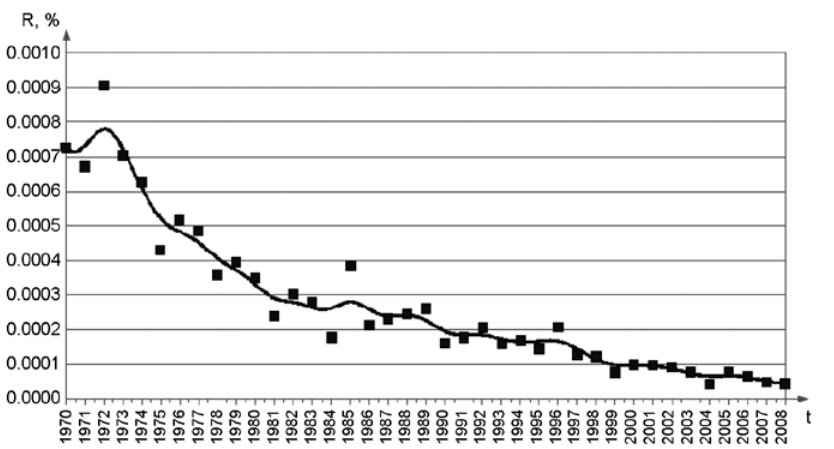
Fig. 1. The percentage of people who died in air accidents relative to all carried passengers in the period between 1970 and 2008